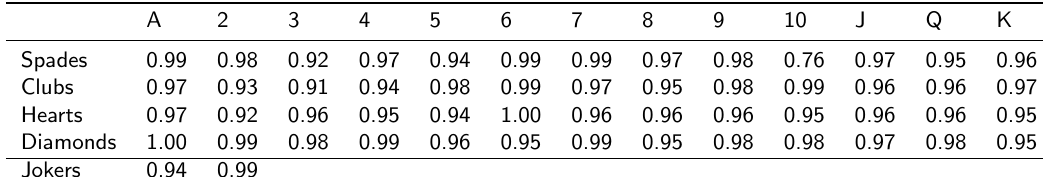
Table 3. Recognition rate (recall) of cards by numbers and